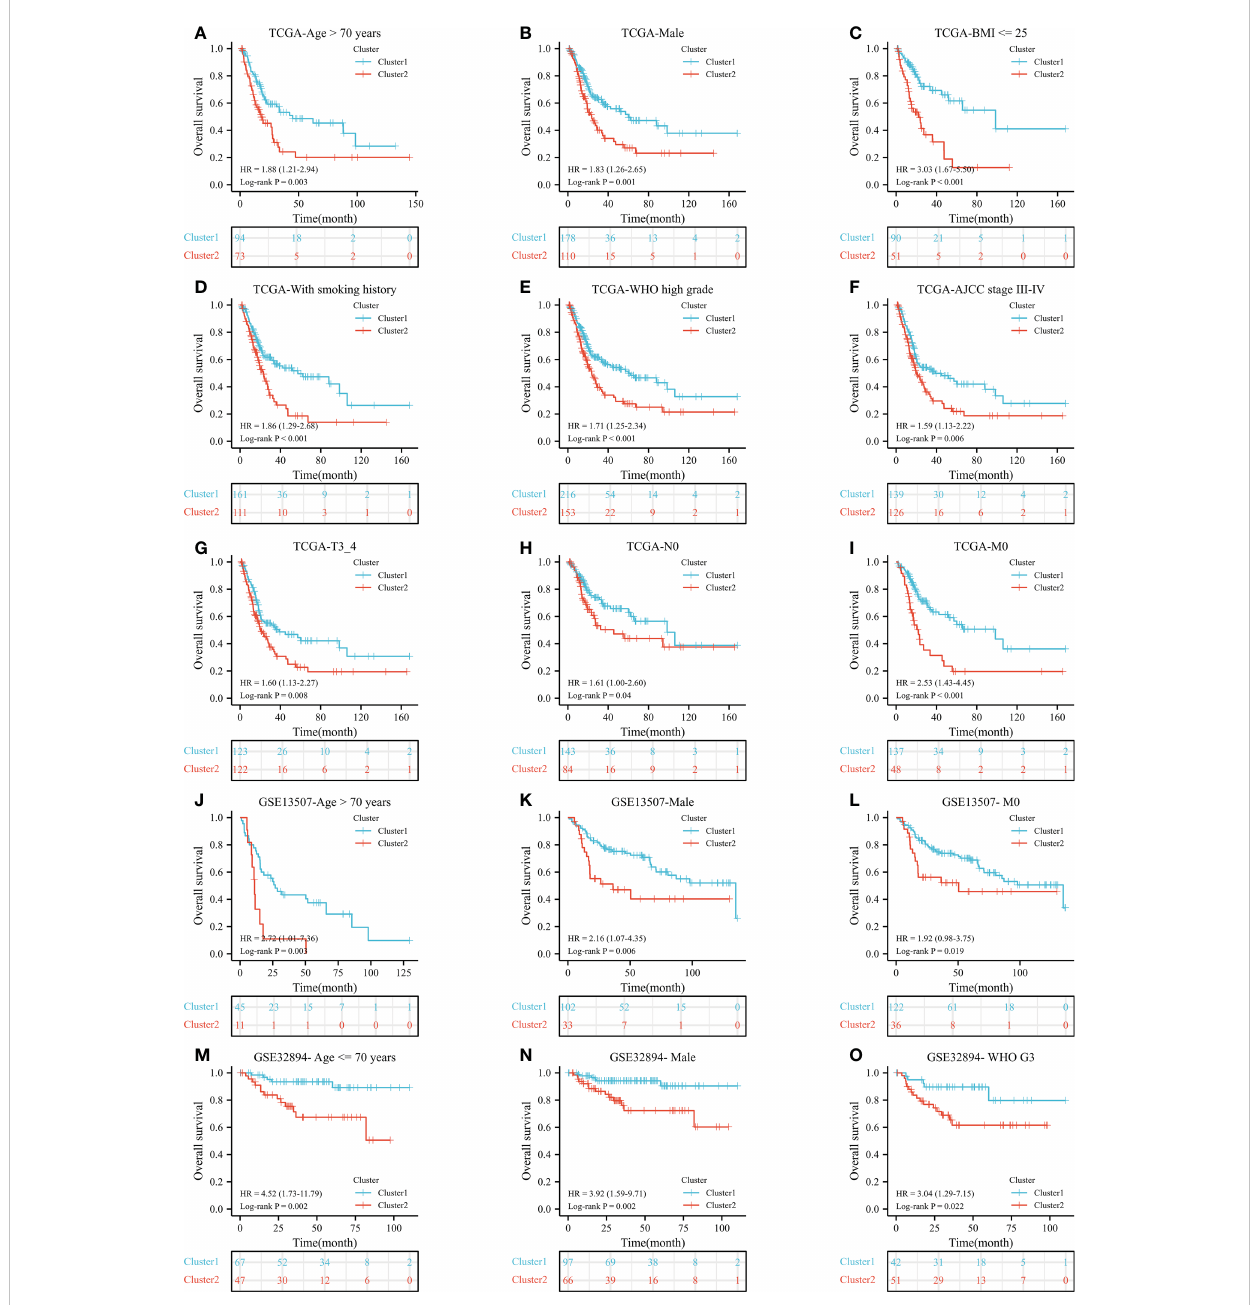
FIGURE 3 The prognostic ability of the cluster in clinical subgroups: Kaplan − Meier analysis results of subgroups in TCGA dataset: age >70 years (A) , male (B) , BMI <= 25 (C) , with smoking history (D) , WHO high grade (E) , AJCC stage III-IV (F) , T3_4 stage (G) , no lymph node metastasis (H) , and no distant metastasis (I) subgroups; In GSE13507 dataset: age > 70 years (J) , male (K) , and no distant metastasis (L) subgroups; In GSE32894 dataset: age <= 70 years (M) , male (N) , and WHO G3 (O) subgroups. N, lymph node metastasis; M, distant metastasis; WHO, World Health